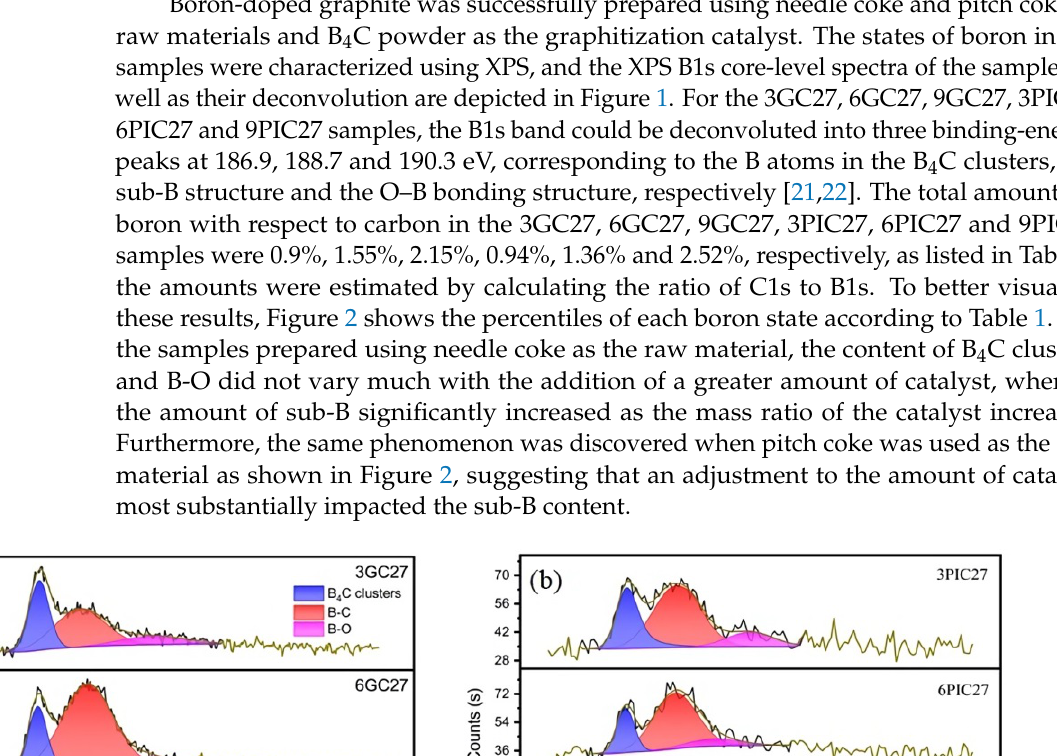
Table 1. Boron concentration in the samples, obtained using XPS.